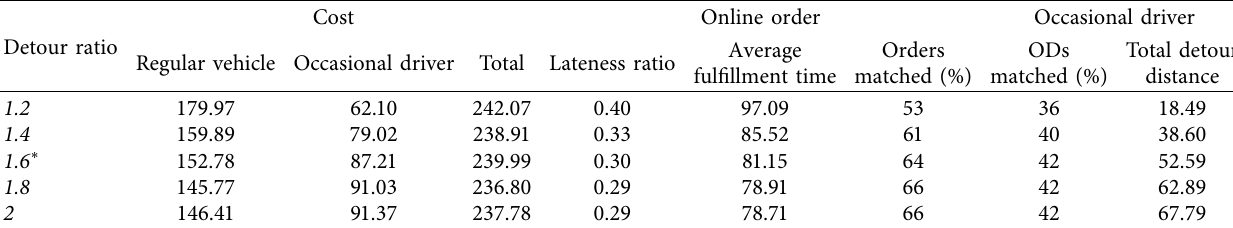
Table 4: Maximum OD detour